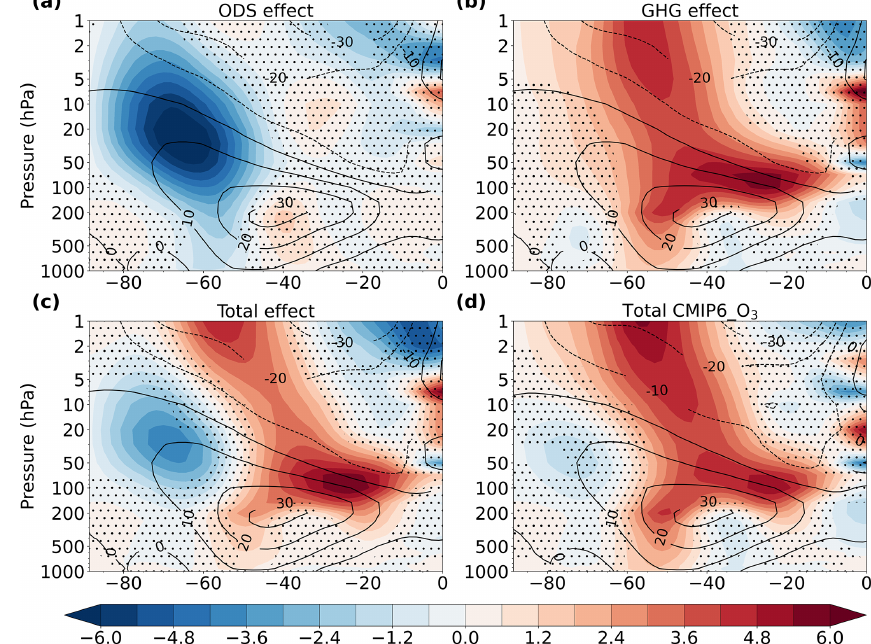
Figure 4. Changes in the November–December zonal-mean zonal wind (ms − 1 ) for each latitude and pressure level (color shading): effect of ozone recovery (a) , effect of GHGs (b) , total effect in INTERACT_O 3 (c) , and total effect in CMIP6_O 3 (d) . The contours depict the current-day (2011–2030) climatology from INTERACT_O 3 in (a) – (c) and from CMIP6_O 3 in (d) . The stippling masks regions where the changes are not significant at the 95% confidence interval based on a two-tailed t test.